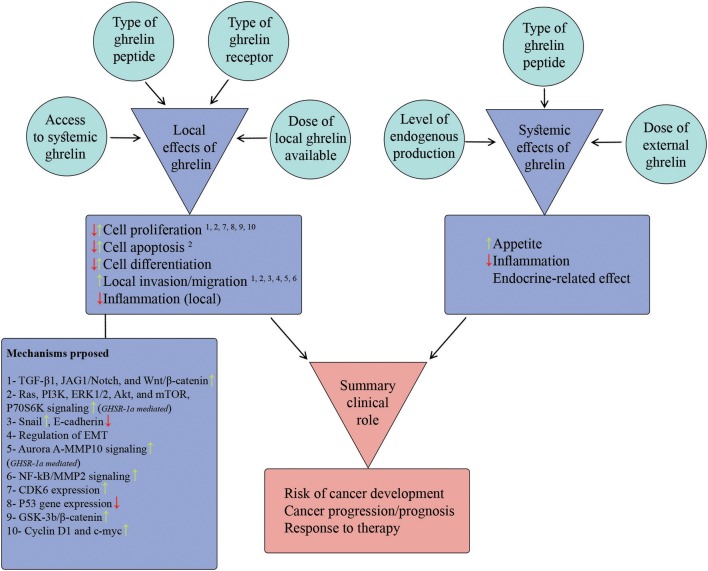
Model proposed to describe summary clinical role of ghrelin in case of each cancer. The figure summarizes the potential local and systemic effects of ghrelin attributable to cancer biology (items listed in two purple boxes) as wells as the candidate factors that regulate these effects (the items inside surrounding circles). Furthermore, the potential mechanisms proposed so far for local effects of ghrelin are listed in the purple box below the list of local effects. The superscript numbers above each local effect correspond to the potential underlying mechanism(s) from the mechanisms list. The summary clinical role of ghrelin is built-up by relative contributions of local and systemic effects. Based on the direction and relative dominance of local and systemic effects, the summary effect on different aspects of cancer (the items in red box) could be promoting or protective.